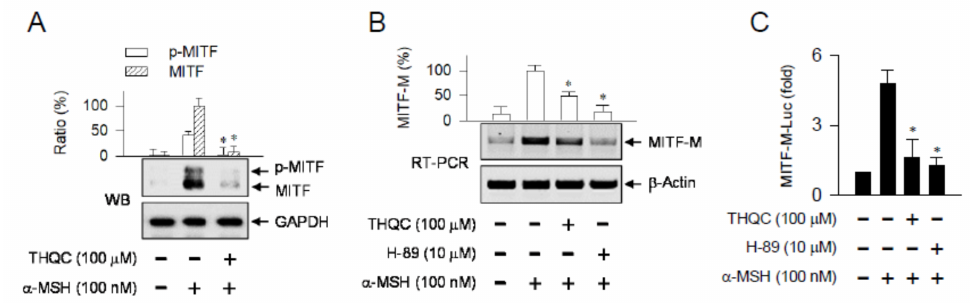
Figure 4. E ff ect of THQC on MITF-M expression. After pretreating with THQC for 2 h, B16-F0 cells were stimulated with α -MSH for 4 h ( A ) or 2 h ( B ) in the presence of THQC. ( A ) Western blot analysis (WB) of MITF with the internal control GAPDH. ( B ) Semi-quantitative RT-PCR analysis of MITF-M with the internal control β -actin. ( C ) After transfection with the MITF-M ( − 2200 /+ 95)-Luc reporter in combination with the Renilla control vector, B16-F0 cells were stimulated with α -MSH for 18 h in the presence of THQC. The cell extract was subjected to a dual luciferase assay. Firefly luciferase activity, reporting the promoter activity of the MITF-M gene, is represented as relative fold after normalizing to Renilla activity. * p < 0.05 vs. α -MSH